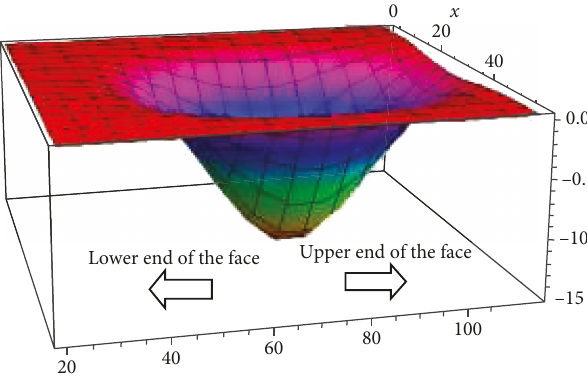
Figure 11: Three-dimensional distribution of roof de fl ection.